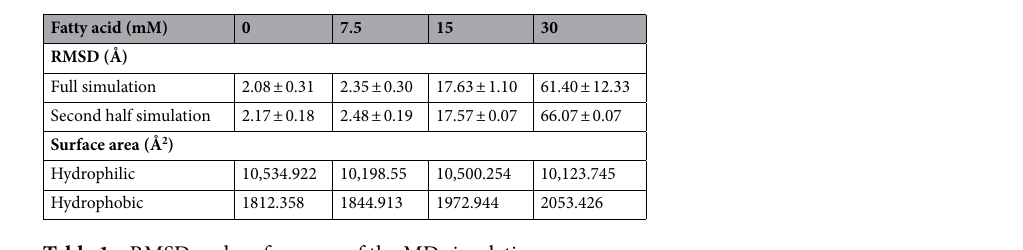
Table 1. RMSD and surface area of the MD